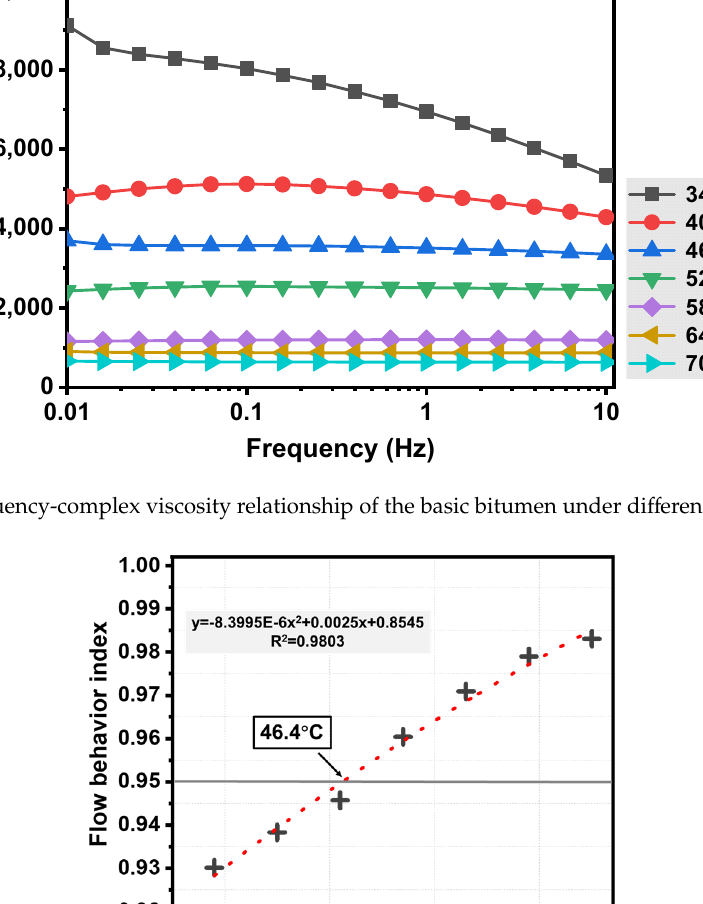
Figure 4. Frequency-complex viscosity relationship of the basic bitumen under different temperatures. Table 5. Fitted results of flow behavior index at different temperatures.